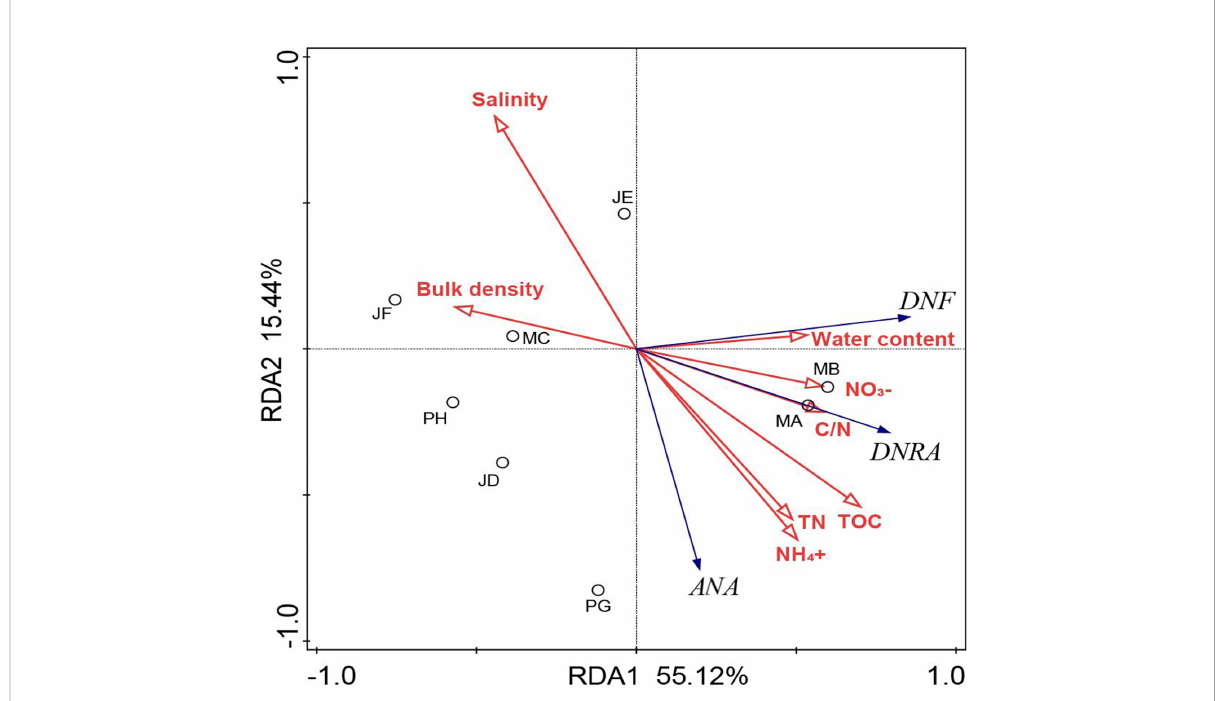
FIGURE 4 Ordination diagram showing the results of RDA of NO 3 - reduction processes and soil physicochemical characteristics. The hollow circles represent individual sediment samples from the eight shrimp ponds in the subtropics Estuary. The red arrows represent soil physicochemical characteristics, and blue arrows represent NO 3- reduction